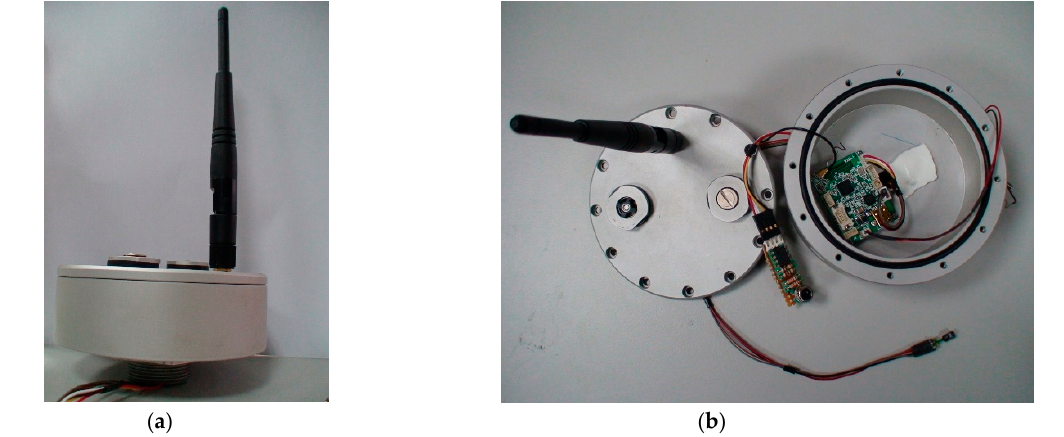
Figure 14. ( a ) Exterior of the sensor node device. ( b ) Interior of the sensor node device.